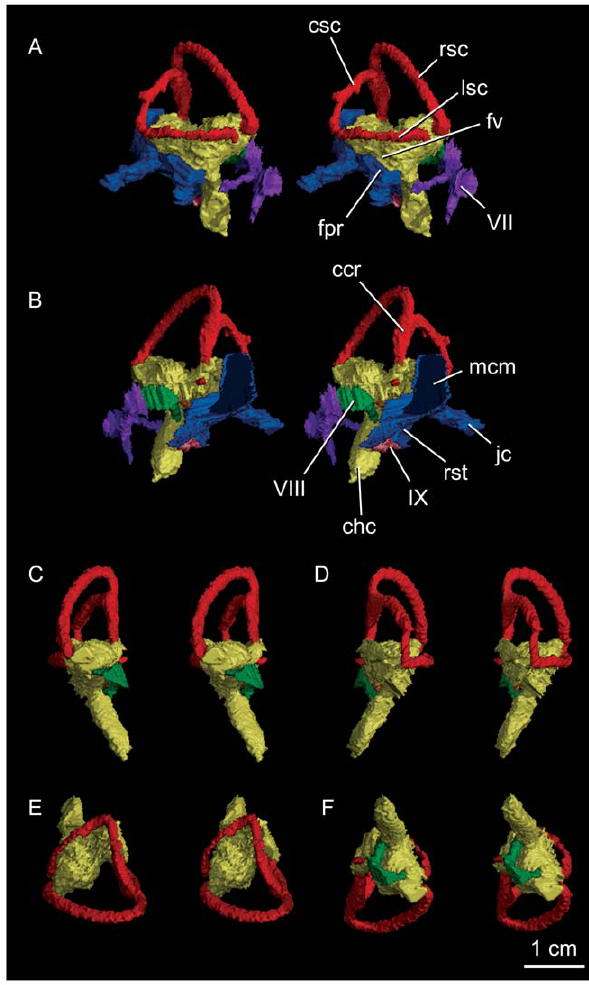
Figure 8. Stereopairs of the right osseous labyrinth of Alioramusaltai (IGM 100/1844). The renderings are in lateral (A), medial (B), rostral (C), caudal (D), dorsal (E), and ventral (F) views. Reconstruction of the facial canal (purple), cavum metoticum (blue), and the independent medial path of the glossopharyngeal nerve (orange) are included in the medial and lateral views. VII, facial canals; VIII vestibulocochlear canals; IX, glossopharyngeal canal; ccr, common crus; chc, cochlear canal; csc, caudal semicircular canal; fpr, fenestra pseudorotunda; fv, fenestra vestibuli; jc, vagal canal; lsc, lateral semicircular canal; rsc, rostral semicircular canal.